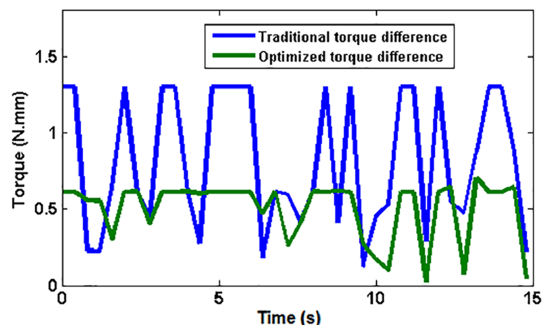
Figure 19. The difference between VSA-torques.